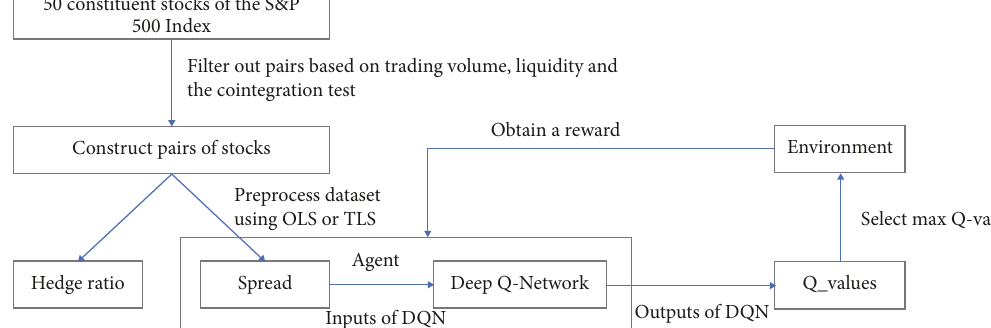
Figure 3: Steps for proposed pairs-trading strategy using the DQN method.